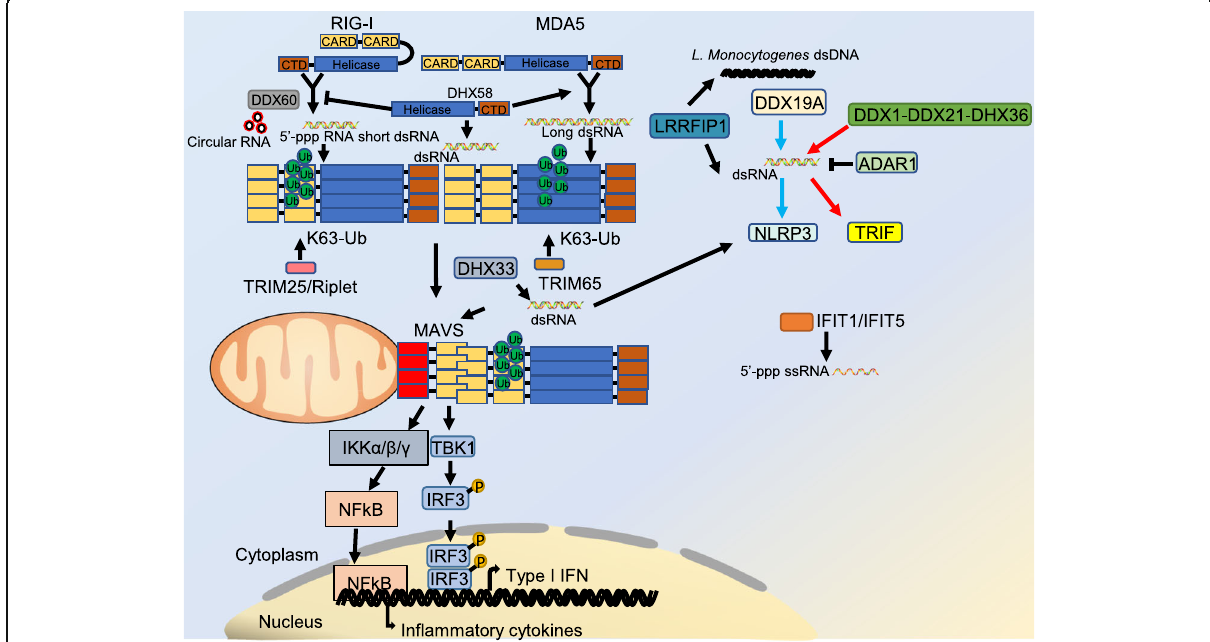
Fig. 1 Cytosolic viral RNA sensing. The RLR family members MDA5 and RIG-I preferentially recognize long dsRNA and 5 ′ - triphosphate short dsRNA, respectively. RIG-I can also recognize circular RNA synthesized in vitro and derived from virus. After RNA ligand binding, RIG-I and MDA5 undergo conformational changes that expose N-terminal CARDs to mediate downstream signaling. Riplet/TRIM25 or TRIM65-mediated K63-linked ubiquitination induces RIG-I and MDA5 activation, respectively. Both RIG-I and MDA5 can interact with MAVS on the outer membrane of mitochondria and activate MAVS to form signal platform, which further activates NF κ B via the IKK complex or IRF3 via TBK1. DHX58 is reported to facilitate MDA5 activation, whereas it drives the inactivation of RIG-I. Besides, DDX1-DDX21-DHX36 complex recognizes viral dsRNA and activates TRIF pathway. DDX19A senses viral RNA and activates NLRP3 inflammasome. DHX33 senses cytosolic viral dsRNA and interacts with MAVS to activate innate immune signaling. DDX60 is needed for the activation of RIG-I by binding to viral RNA. ADAR1 recognizes viral dsRNA suppresses dsRNA-induced signaling. LRRFIP1 recognizes dsRNA and L. monocytogenes dsDNA. Moreover, IFIT1 and IFIT5 can recognize 5 ′ - triphosphate